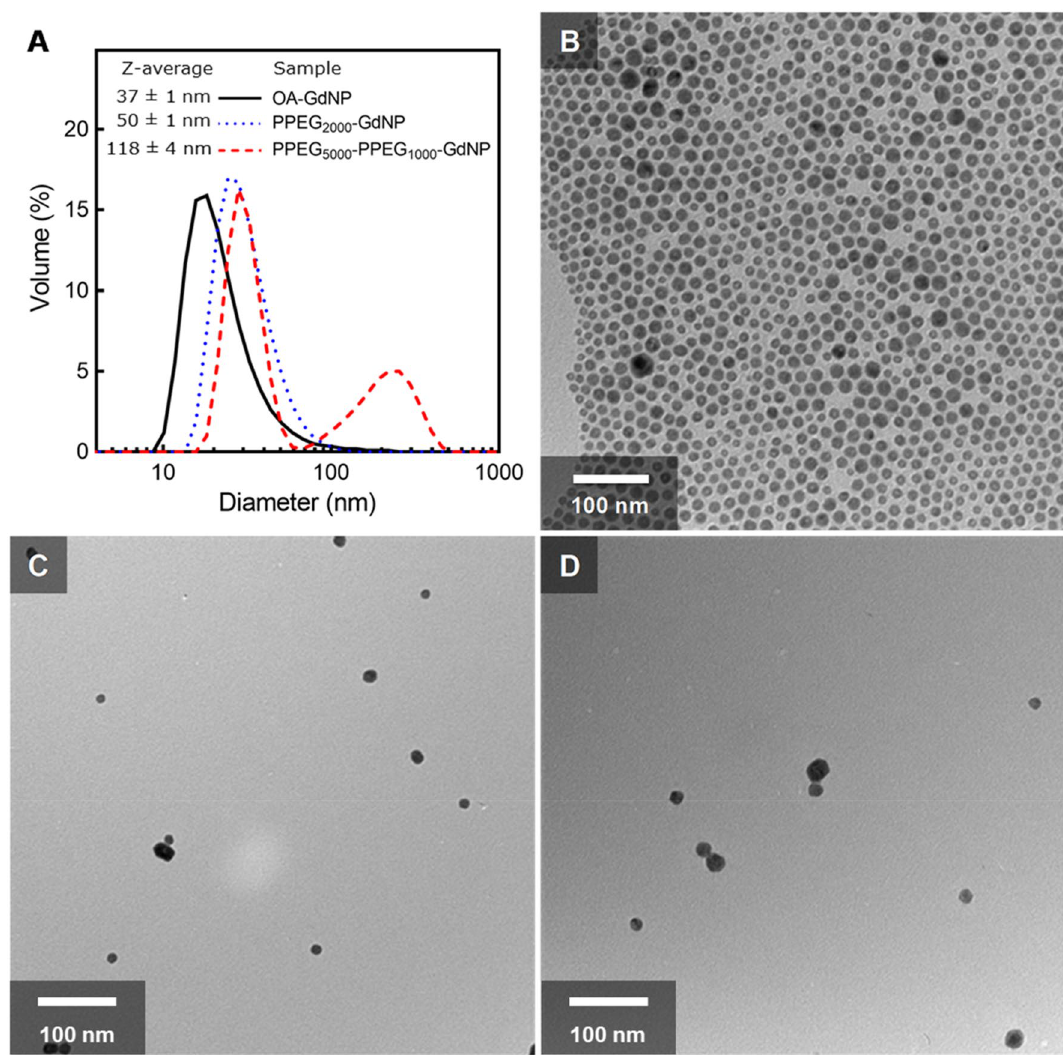
Figure 2. Size distributions and microscopy images of the synthesized GdNPs. ( A ) DLS volume diameter distributions of OA-GdNP in cyclohexane, and PEG 2000 -GdNP and PEG 5000 -PEG 1000 -GdNP in water. Representative TEM images of ( B ) OA-GdNP, ( C ) PEG 2000 -GdNP and ( D ) PEG 5000 -PEG 1000 -GdNP. The scale bar in ( B ) applies to all TEM